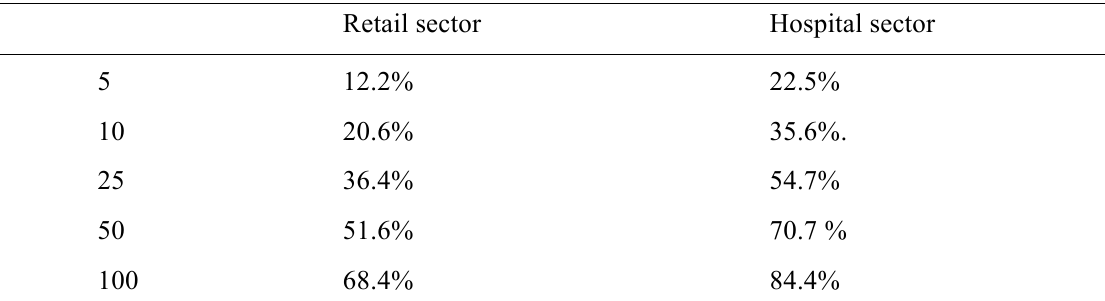
Table 1B: Distribution of sales by number of top selling substances in 2009